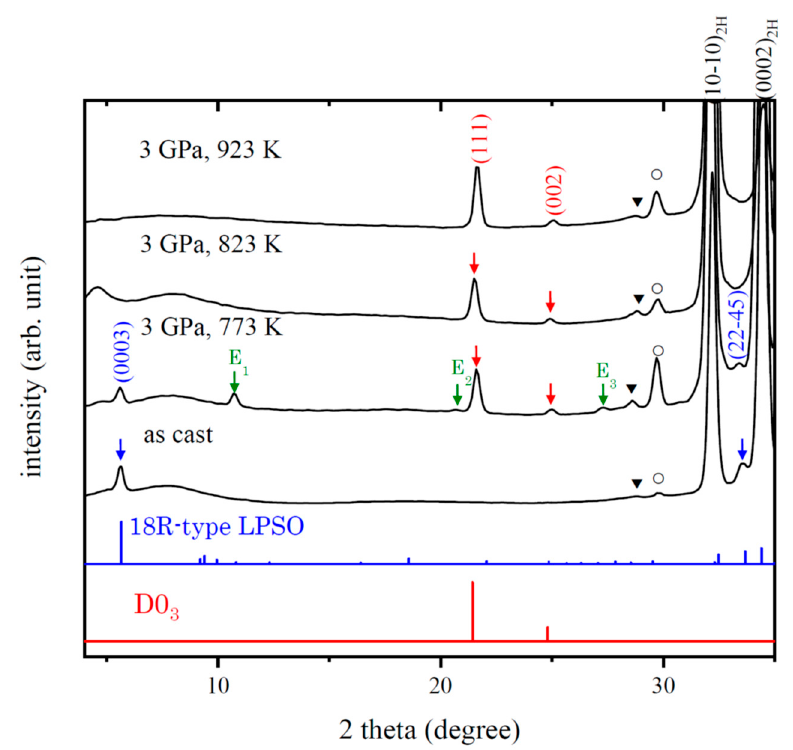
Figure 1. X-ray diffraction patterns of Mg 97 Zn 1 Y 2 cast alloy and the alloy recovered after being annealed at 3 GPa for 2 h at various temperatures. The blue and red lines show the estimated peak position and intensity from the 18R-type LPSO [5] and D0 3 superlattice listed in Table 1, respectively. The index and arrows in blue and red indicate coinciding peaks to 18R-type LPSO and D0 3 , respectively. The peaks from Y 2 O 3 and Y are indicated by a circle ( 〇 ) and triangle ( ▼ ), respectively. Table 1. Crystal information of high-pressure phase (D0 3 ) estimated by XRD. Chemical